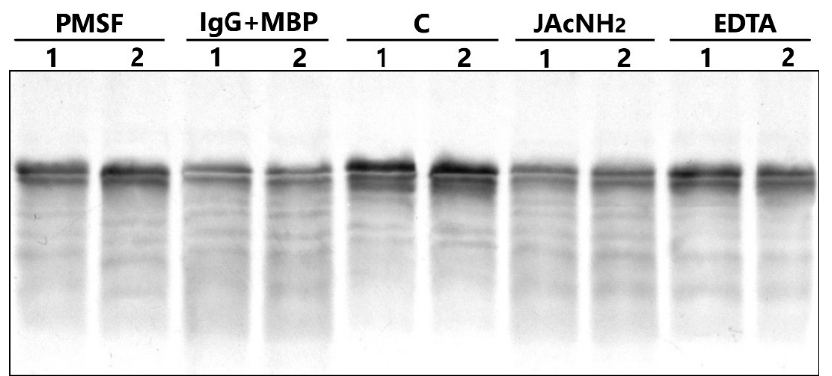
Figure 5. SDS-PAGE analysis of the hydrolysis of MBP by IgG in absence and presence of different inhibitors. Lanes 1 and 2 correspond to two repeats. The mixtures containing 1 mg/mL MBP and 0.2 mg/mL IgG were incubated for 24 h. Lanes C—control reaction mixture containing MBP and 20 mM Tris-HCl (pH 7.5) without IgG; lanes IgG + MBP—mixture of IgG and MBP without inhibitors; lanes PMSF, JAcNH2, EDTA—mixture of IgG and MBP in the presence of relevant inhibitors. Table 2. The kinetic parameters characterizing efficiency of MBP hydrolysis by two individual IgG preparations of patients with bipolar disorder.